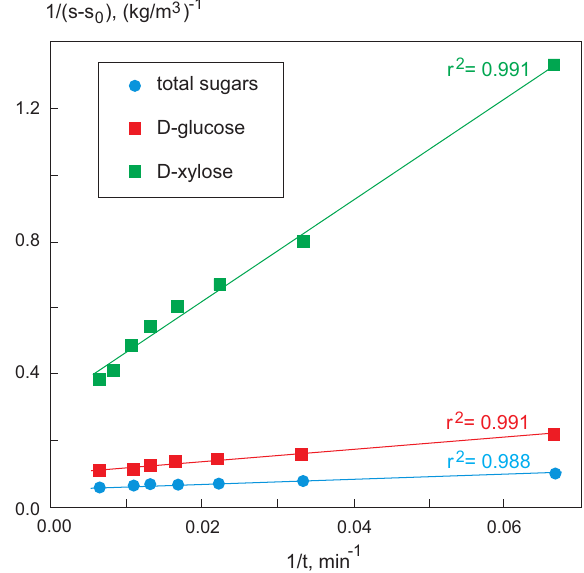
Figure 5. Adjustments for kinetic determination. Table 6. Hydrolysis, r , and generation rates of D -glucose, r g , and D -xylose, r x , kg m − 3 min − 1 .